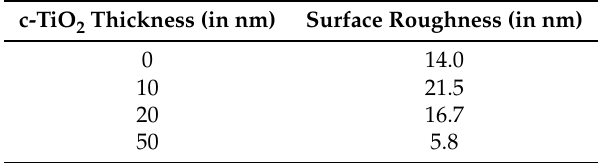
Table 2. The surrface roughness of the grown CsPbBr 3 QD films vs. CL thickness.